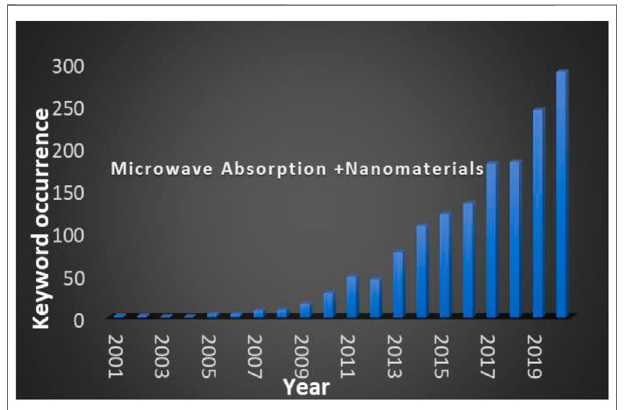
FIGURE 2 | Schematic illustration of electromagnetic wave propagation through a